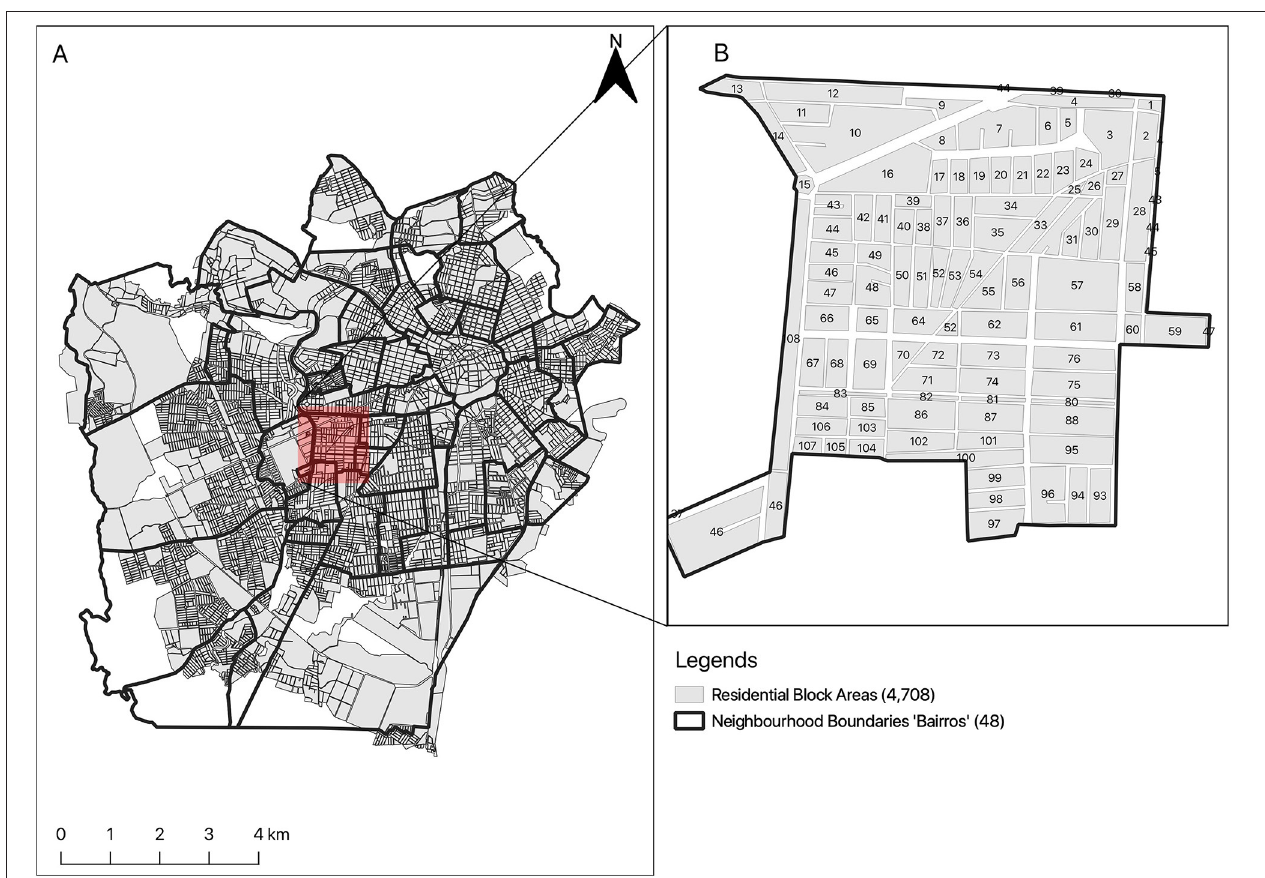
FIGURE 2 | The study area of Campina Grande showing the spatial configuration of the neighborhoods (A) and block areas (B)